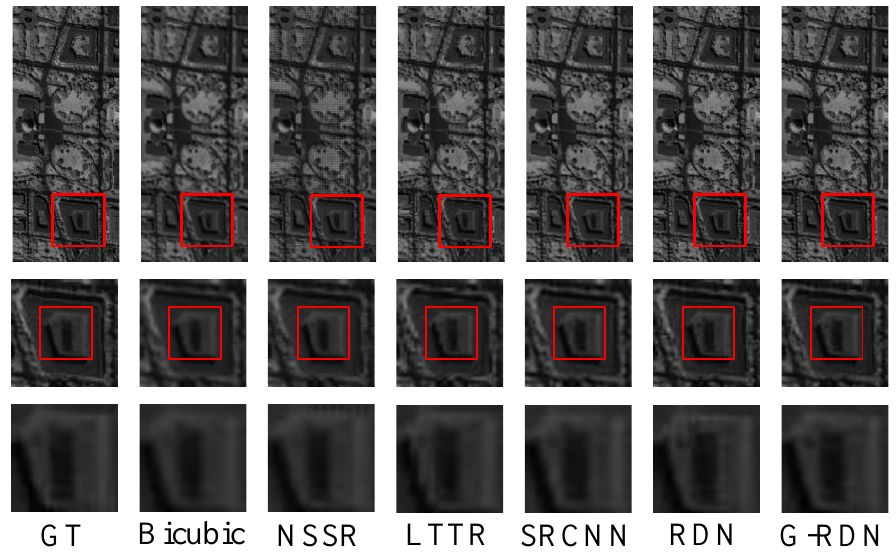
Figure 13. Visual exhibition of the reconstructed Washington DC Mall at the scaling factor of